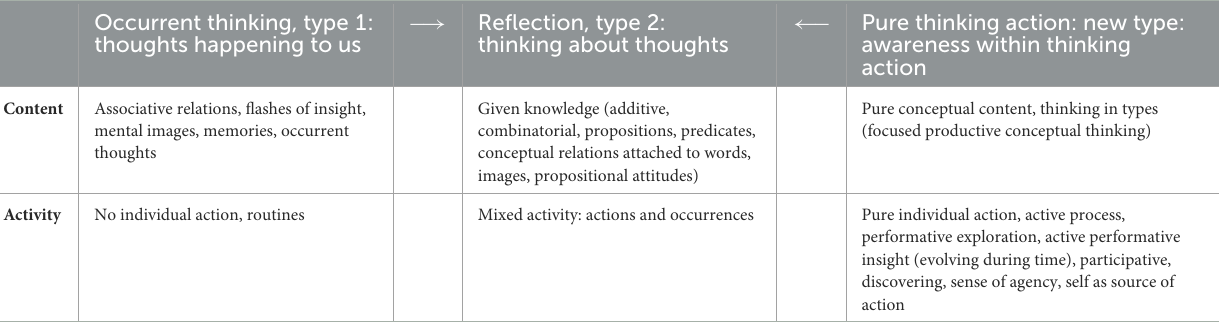
TABLE 3 Main types of